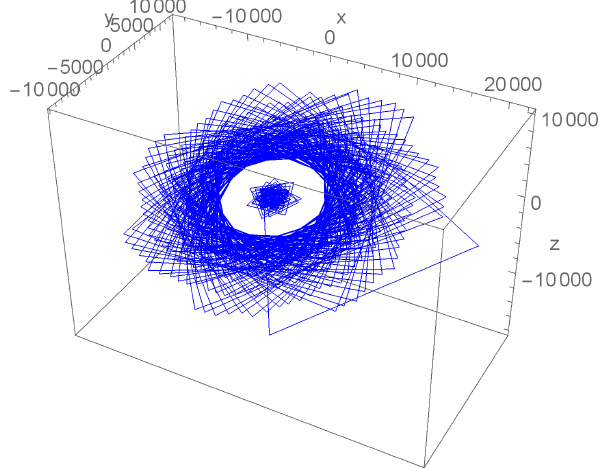
Figure 12. Graph of attractors x n y n z n in 3D for α = 2.5, β = 0.05, γ = 0.7, δ = 0.6, ζ = 3.5, η = 0.05, µ = 0.01, ε = 4.1, υ = 0.09, ρ = 0.02, σ = 0.04, ω = 0.06. with initial conditions x 0 = 0.1, y 0 = 0.02 and z 0 =